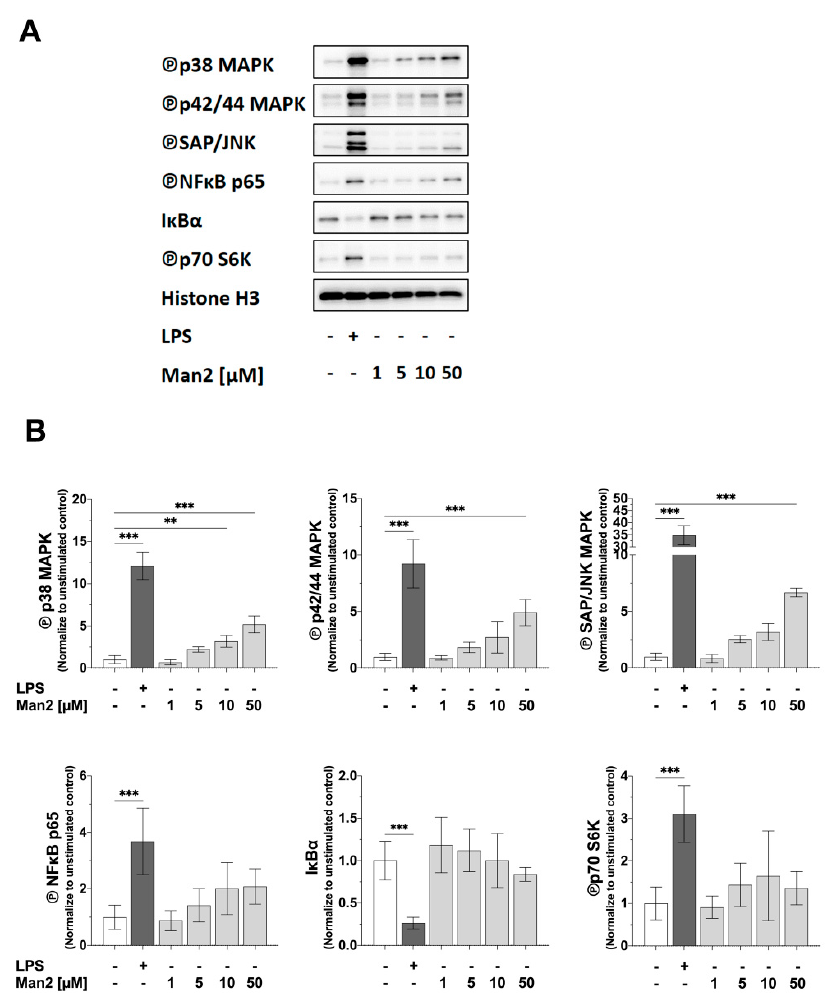
Figure 6. Effect of Man2 on activation of intracellular MAPK-, NF κ B-, and mTOR-signaling pathways in BMDCs. BMDCs derived from C57BL/6 mice (1 × 10 6 cells/mL) were stimulated with either 1.0 to 50 µ M Man2 or 10 µ g/mL of LPS. ( A ) After 30 min of stimulation, 1 × 10 6 cells were lysed and target proteins in lysates were detected by Western blotting. ( B ) The intensities of protein bands were quantitated by Image J software. Data are mean values ± SD of four independent experiments. ** p < 0.01, *** p < 0.001 in 2-way ANOVA tests.